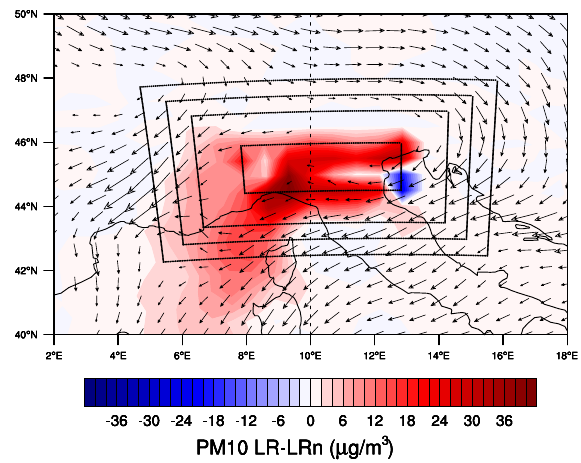
Fig. 8. Contour plot of the average difference of C LRn − C LR for PM10 for the case study 2011-06-17 at 07:00 UTC and the wind field at 850 hPa.